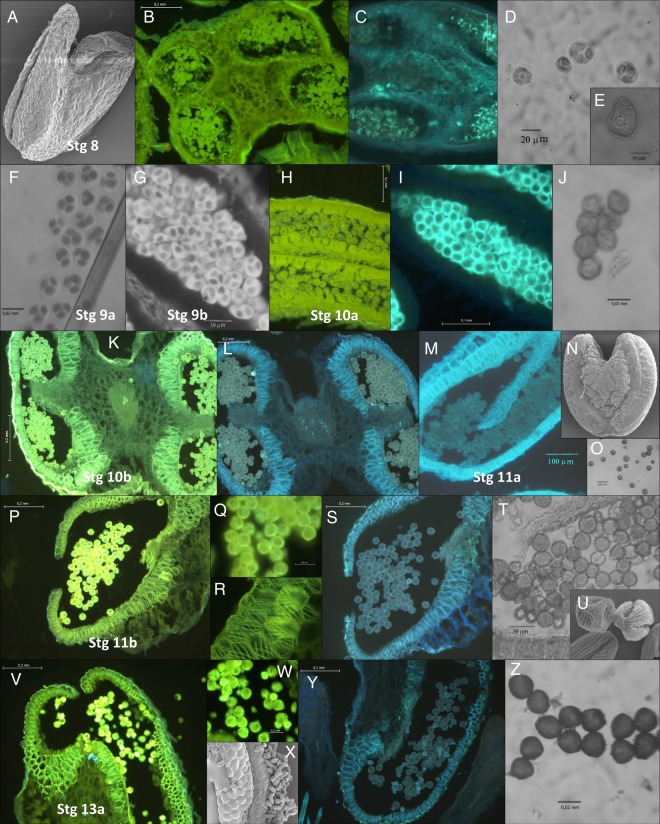
Micrographs of anther and pollen development of F.× ananassa flower buds at different developmental stages (Stg): stage 8 (A–E), stage 9a (F), stage 9b (G), stage 10a (H–J), stage 10b (K and L), stage 11a (M–O), stage 11b (P–U) and stage 13a (V–Z). Histological sections embedded in historesin are stained with Auramine O (green coloured) and aniline blue (blue coloured). Non-coloured pollen photographs are directly observed after squashing. Three-dimensional images of anthers and pollen were acquired by scanning electron microscopy.